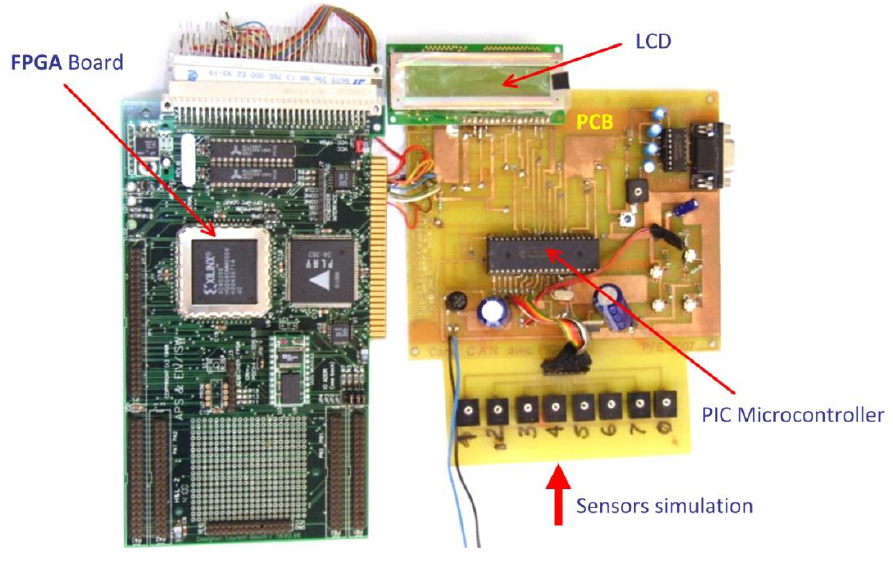
Figure 14. Photograph of the gas identification module